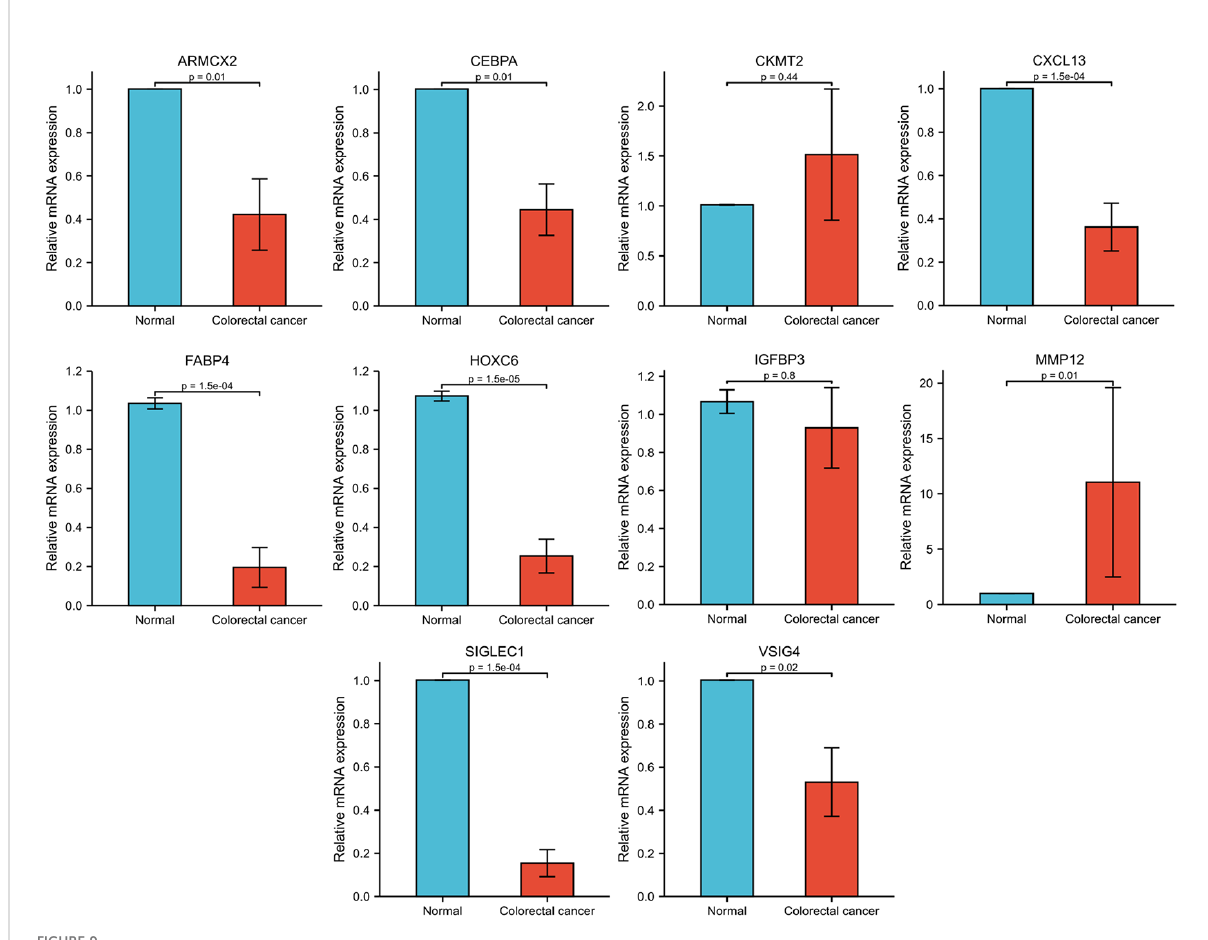
FIGURE 9 Expression information of genes in NR-signature based on CRC and normal